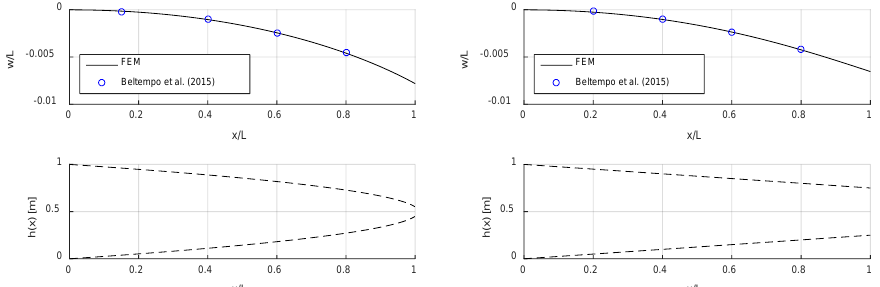
Table 1. Modal analysis for double-tapered cantilever beams.